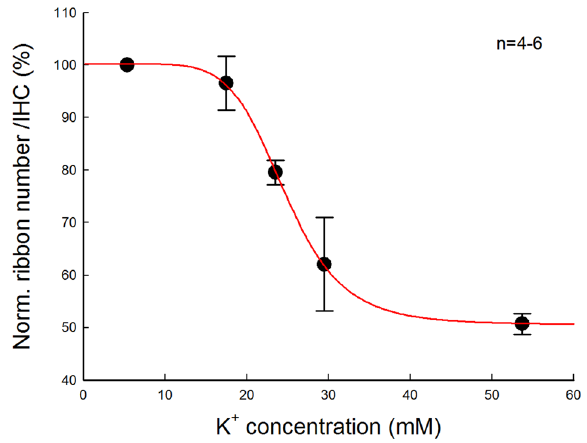
Fig. 2 Dose-curve of K + -induced ribbon degeneration in IHCs. One cochlea was incubated with one concentration of K + and another cochlea of the same mouse was incubated in the NES (K + = 5.37mM) as control. The data pooled from all cochlear turns were averaged and normalized to that in the control cochlea of the same mouse. N is the mouse number at each data point. A smooth solid line represents data fi tting to a Hill ’ s function y = y